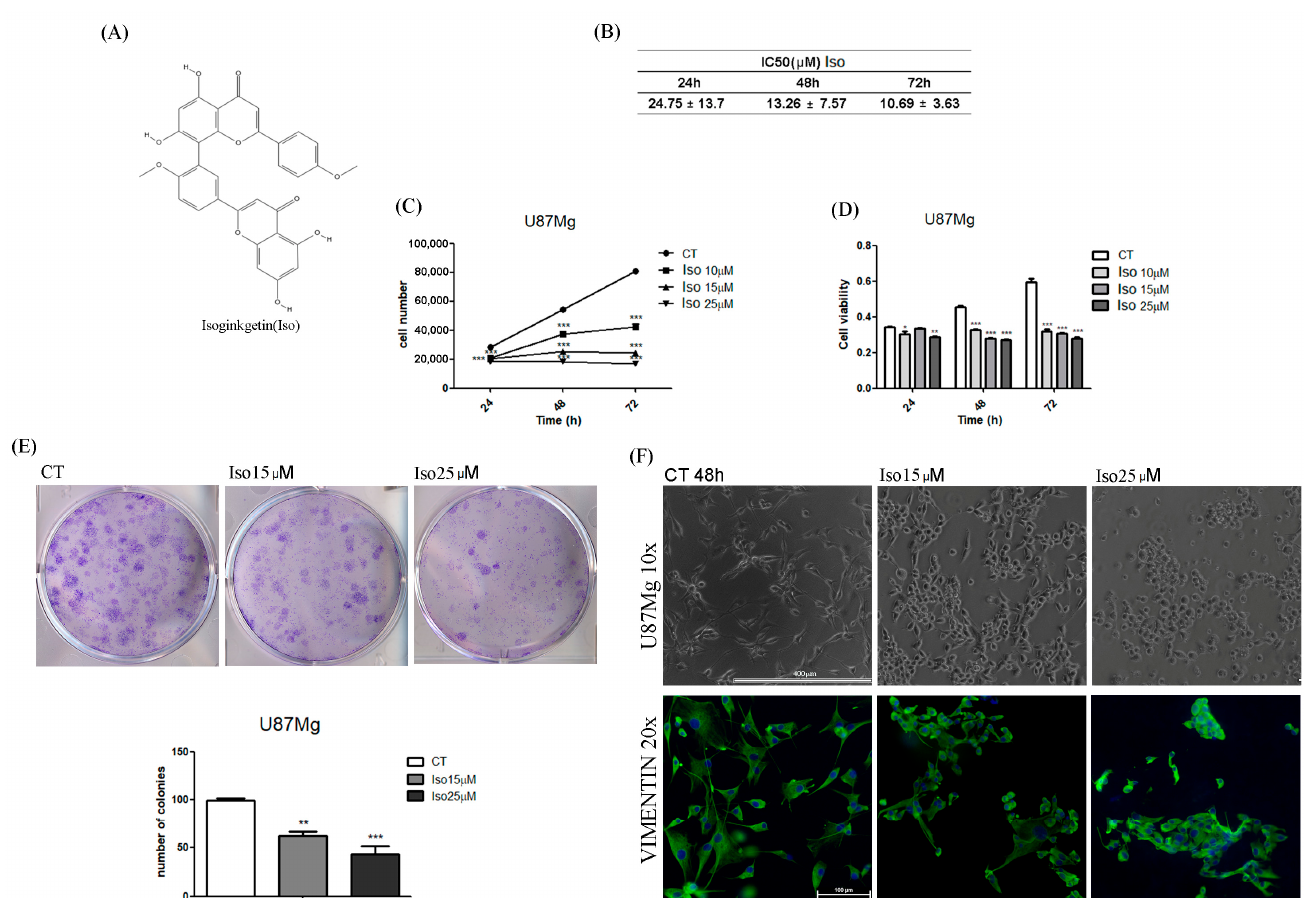
Figure 1. ( A ) Chemical structure of Isoginkgetin. ( B ) IC50-values of U87MG cells after 24, 48, and 72 h of treatment with Iso. ( C ) Time and dose-dependent growth inhibition of U87MG cells treated with Iso at different concentrations (10, 15, 25 µ M). ( D ) Cell viability of U87MG cells after treatment with Iso (10, 15, 25 µ M) for 24, 48, and 72 h. ( E ) Representative images and count of the colonies in U87MG at 12 days from treatment with Iso 15 and 25 µ M. ( F ) Morphological changes of U87MG treated with Iso 15 and 25 µ M for 48 h; (up) brightfield images acquired by a phase contrast microscope (Evos, Life technologies) at 10 × magnification and (down) vimentin fluorescence images acquired by a fluorescence microscope (Axiophot 2 Zeiss) at 20 × magnification. Values are the means ± SEM of three individual experiments: one-way ANOVA test, Dunnett’s multiple comparison test, * p values < 0.05. According to GraphPad Prism ** p value 0.001 to 0.01 (very significant), *** p value 0.0001 to 0.001 (extremely significant).